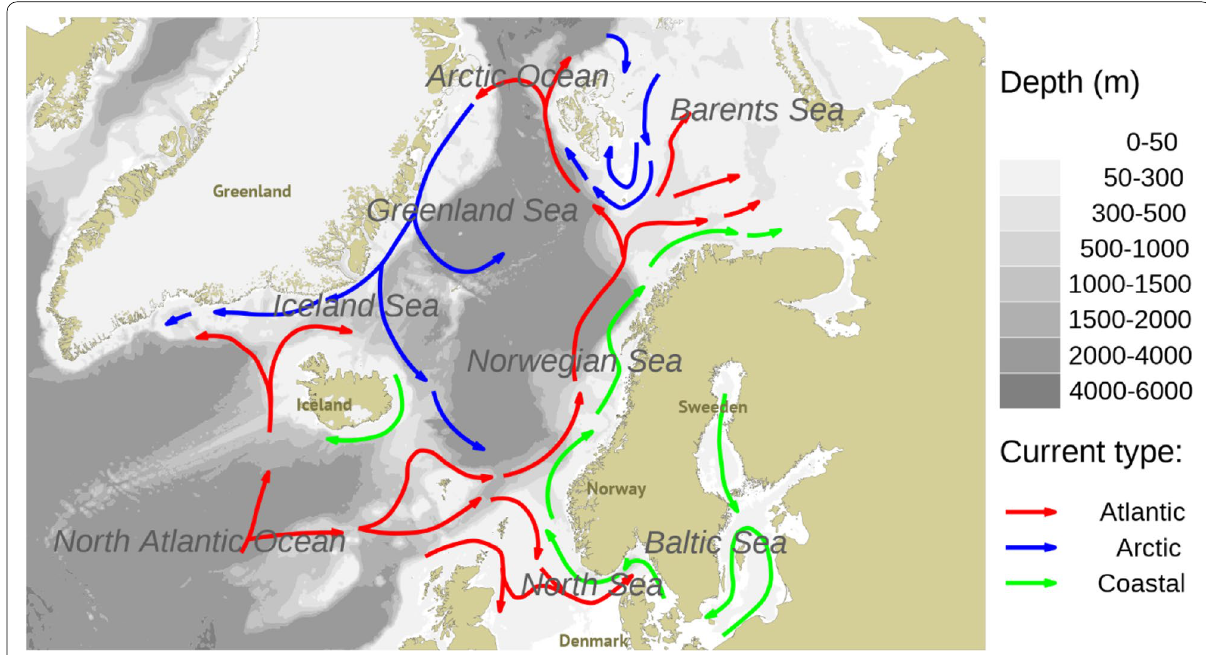
Fig. 1 Topography of the Nordic Seas with a schematic representation of the large-scale surface currents in the region. The map was produced with “ggOceanMaps” [184] by using Norway’s IMR’s GeoServer [93] and [105] for ocean